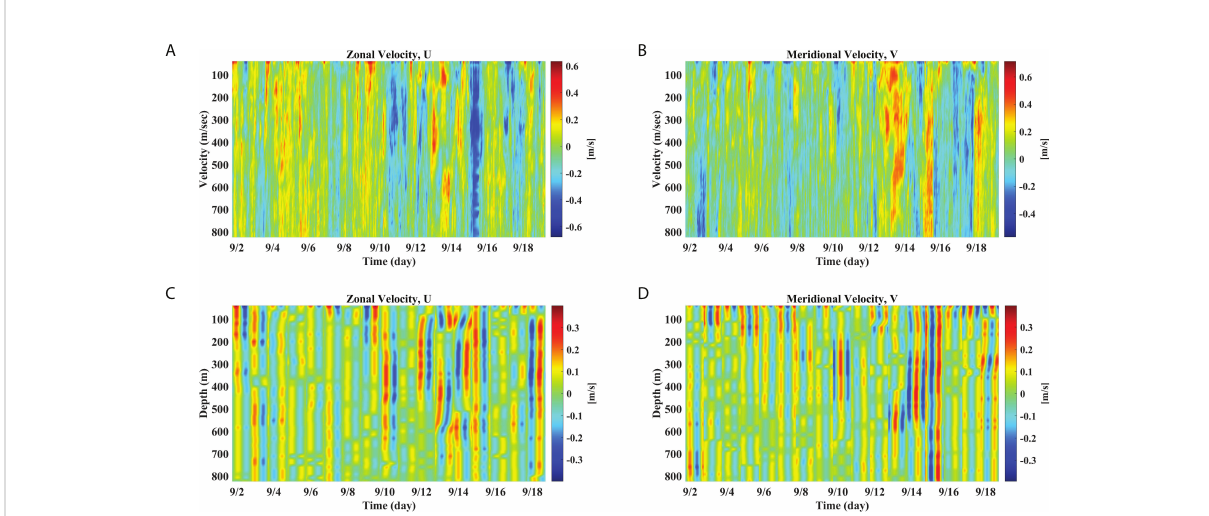
FIGURE 4 The depth – current pro fi les are presented, obtained from the cruising R/V ISABU during the period from September 1 to 19, including the interval of glider mission. The top panels (A) and (B) indicate the measured current velocities for zonal and meridional directions, respectively, while the bottom panels (C) and (D) are the mode-1 DIT fi tted current pro fi les.